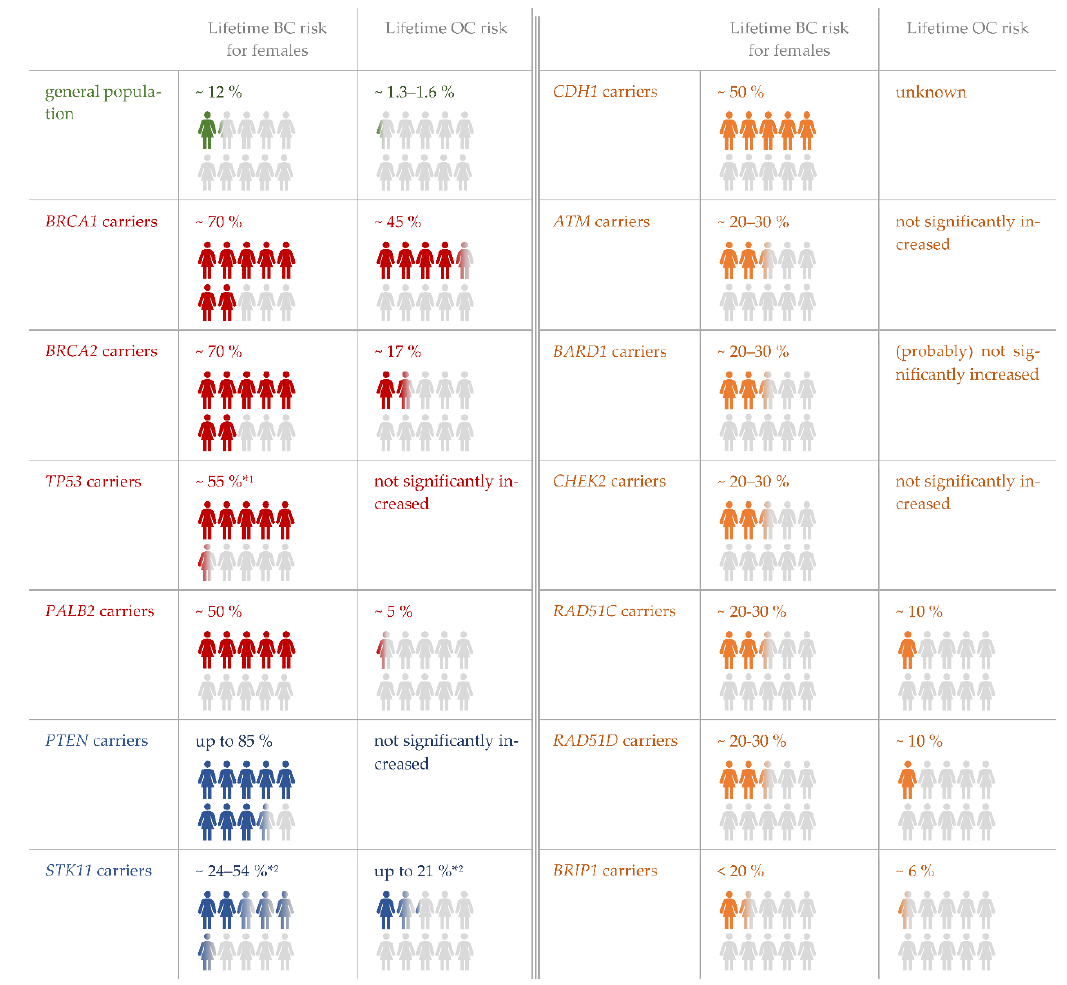
Figure 1. HBOC core genes and associated lifetime risks for breast and ovarian cancer in female carriers of pathogenic germline variants as reviewed in detail in the latest consensus recommendations of the GC-HBOC [1,3]. This illustration was designed for genetic counseling at the University Medicine Greifswald. High-risk genes are marked in red. Moderately penetrant genes are marked in orange. The syndrome-associated genes PTEN and STK11 are marked in blue. * 1 Lifetime breast cancer risk for females from families with Li – Fraumeni syndrome, * 2 Lifetime risks for breast cancer and ovarian cancer (often sex cord tumor with annular tubules) in Peutz – Jeghers syndrome patients according to [4 – 7].